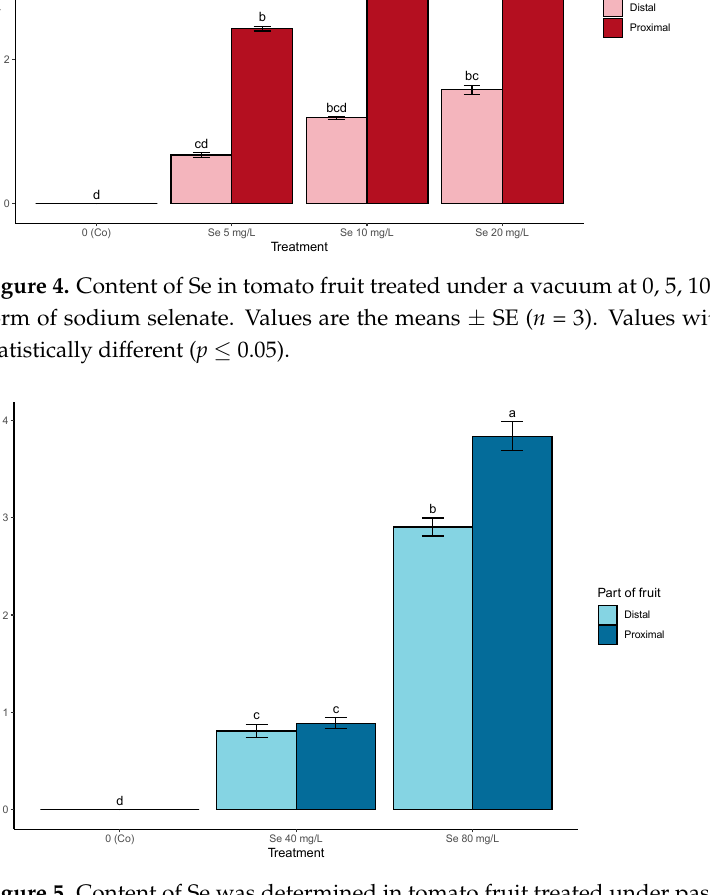
Figure 5. Content of Se was determined in tomato fruit treated under passive immersion at 0, 5, 10, and 20 mg Se L − 1 in the form of sodium selenate. Values are the means ± SE ( n = 3). Values with the same letter are not statistically different ( p ≤ 0.05).